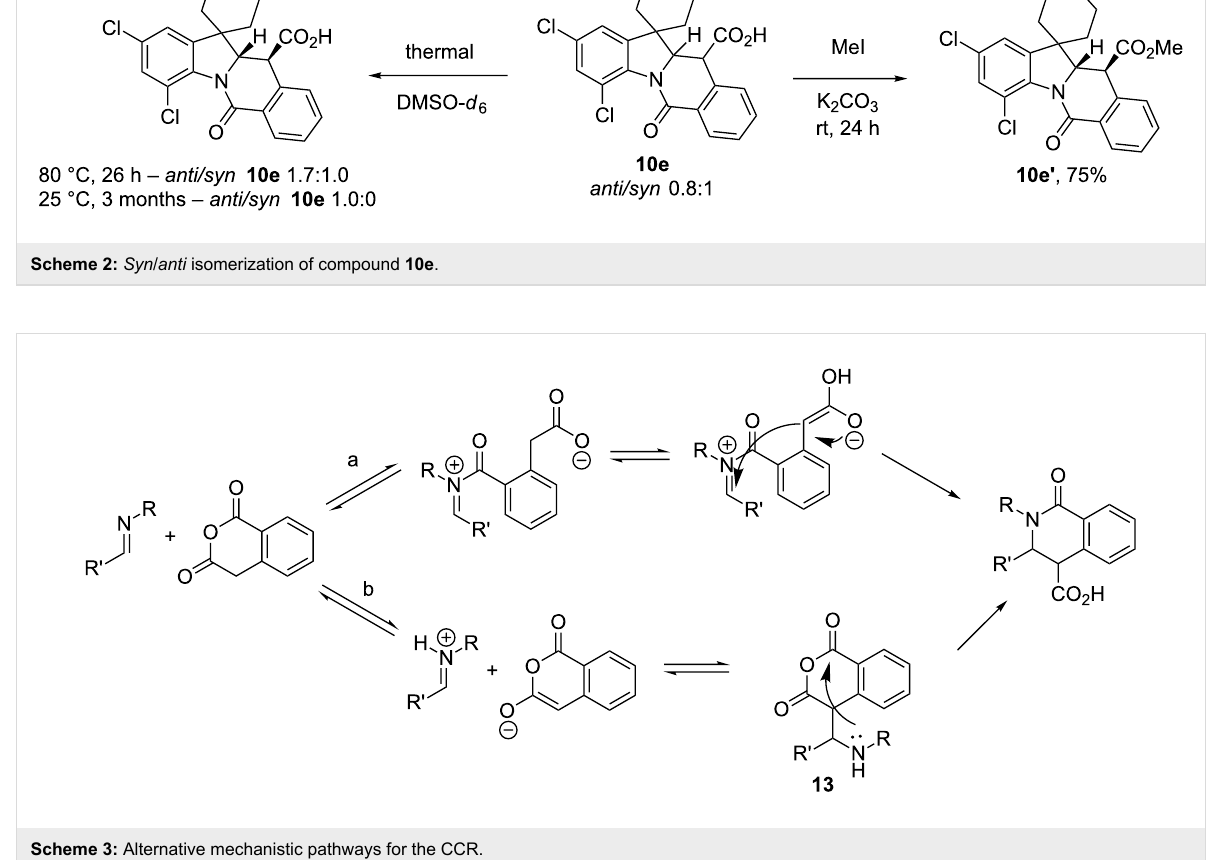
Scheme 3: Alternative mechanistic pathways for the